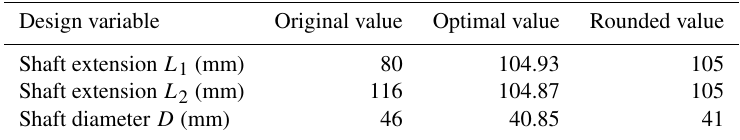
Table 7. The rounding results of the optimal solution.